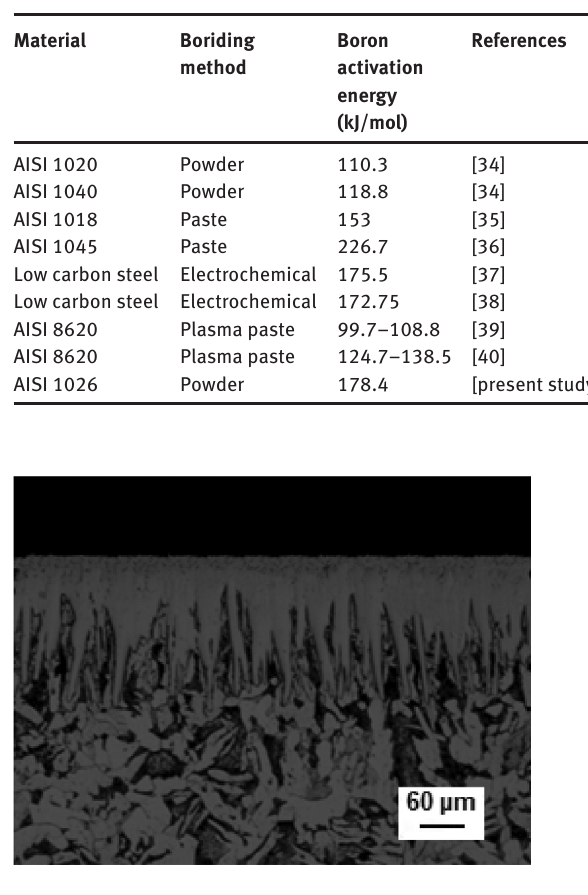
Fig. 11: Optical micrograph of the cross-section of borided AISI 1026 steel at 1253 K during 5